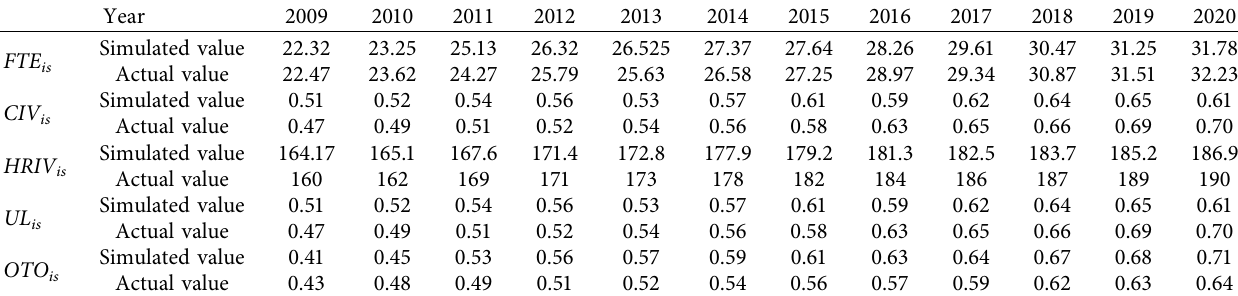
Table 3: Simulated and actual values of the consistency test.